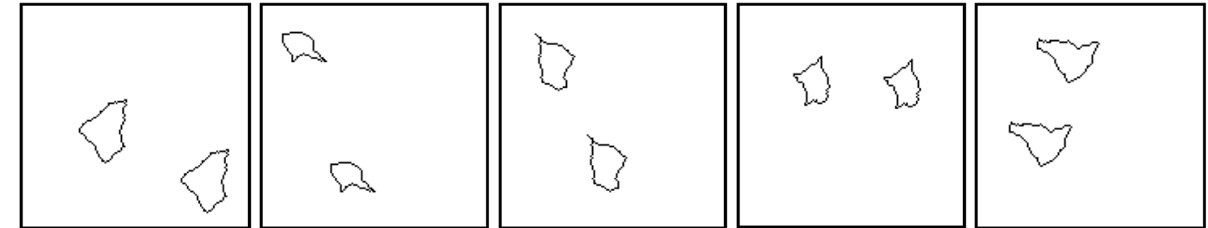
Figure 4. Shapes belonging to category 1 of the SVRT. Are there two identical shapes in the image? Source: [2].